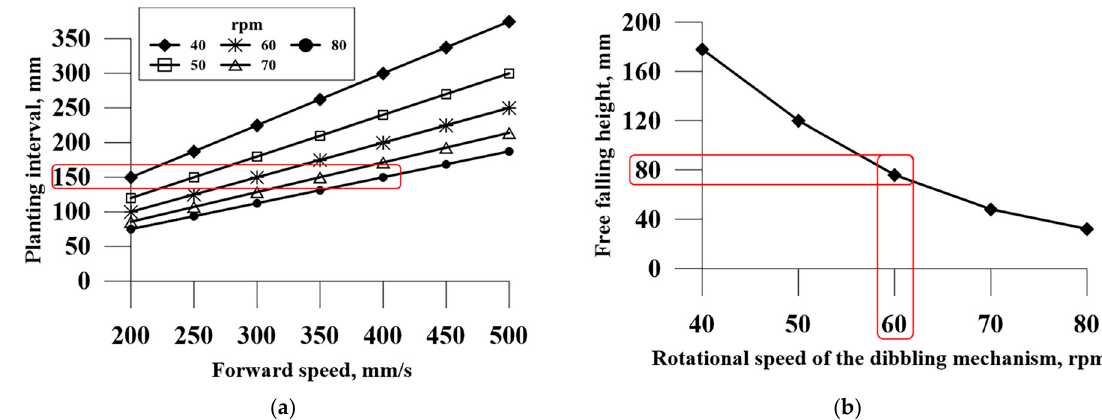
Figure 6. The relation between the planting interval and the rotational speed of the dibbling mechanism for different forward speeds ( a ), and seedling free-falling height, according to the rotational speed of the dibbling mechanism ( b ).